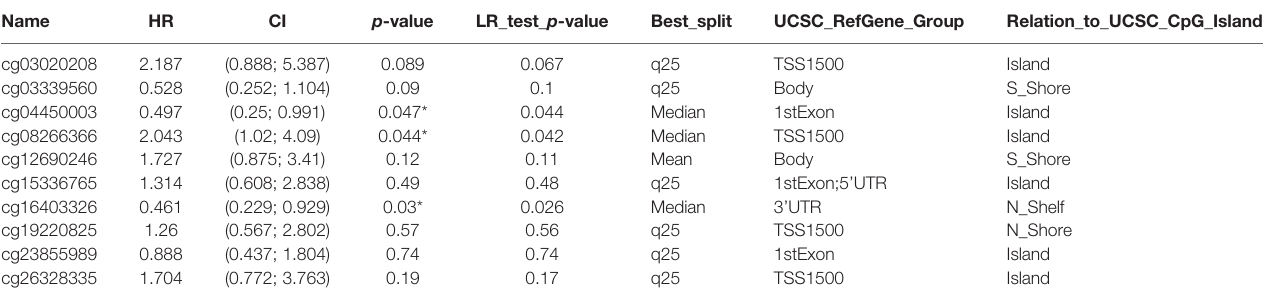
TABLE 4 | The prognostic value of CpG in